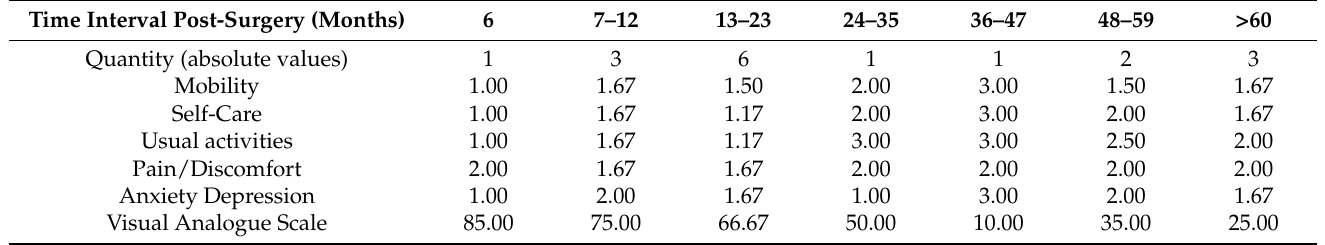
Table 6. Replies of the ED-Q5 questionnaire categorised by time interval post-surgical intervention. Time Interval Post-Surgery